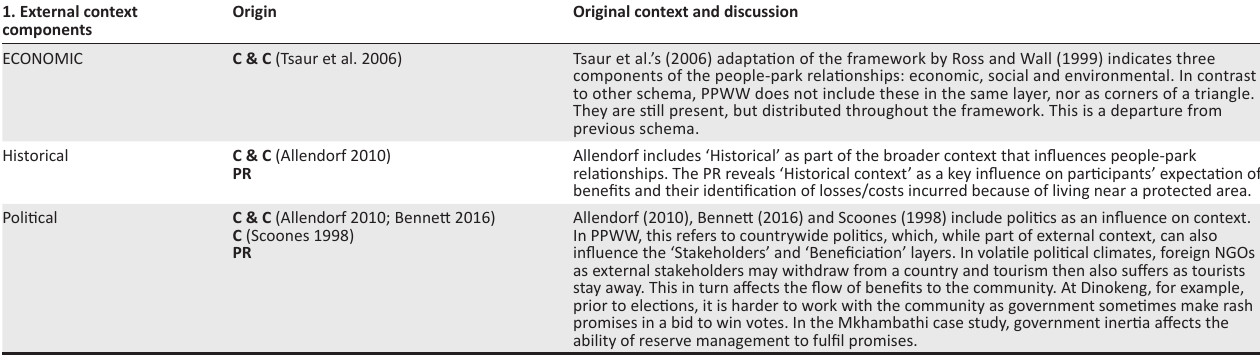
TABLE 1: Layer 1 and components used to build the People Parks Win-Win Framework.